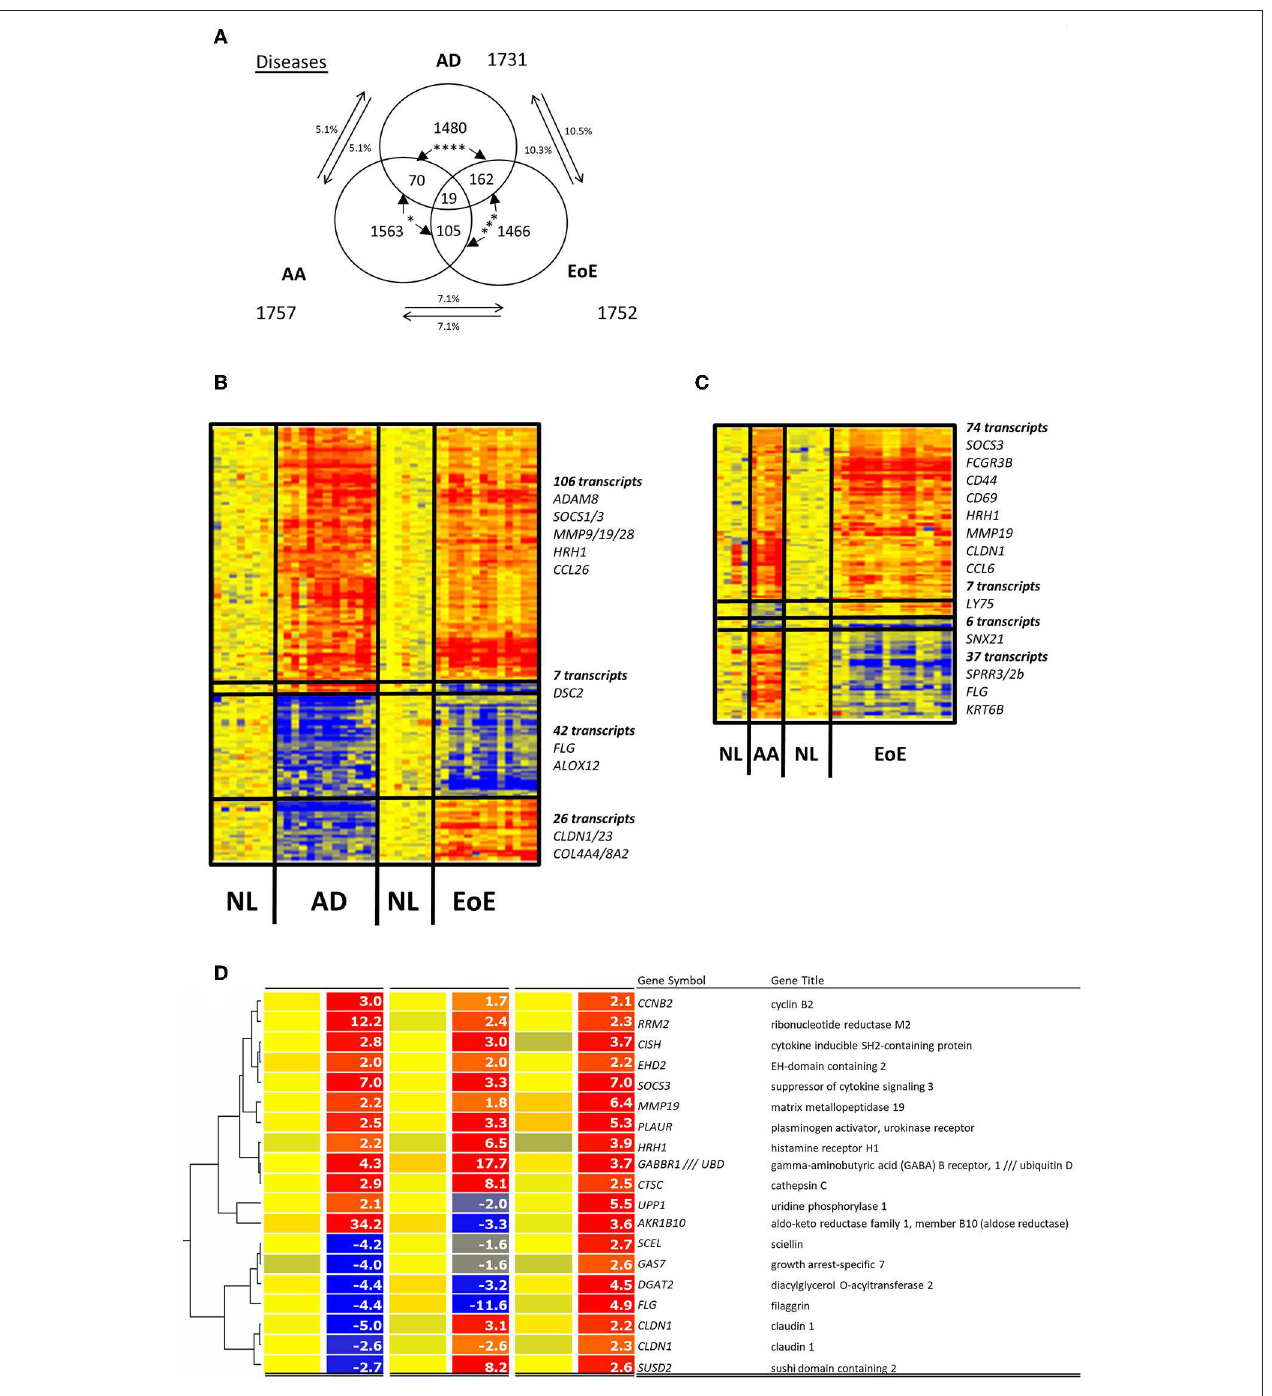
FIGURE 1 | Comparison of EoE, AD, and AA diseases. (A) Venn diagram of dysregulated transcripts in the three diseases is shown. The three amounts of dysregulated genes in EoE, AD, and AA diseases and their respective overlaps are shown, and the number of transcripts is indicated. The percentages of genes in each disease gene group that overlap with those of another disease are shown. Chi-square tests were used to compare transcript overlaps for each disease model with the two other diseases. P -values are shown for each comparison of overlap (between arrows); * p < 0.05; ***p < 0.0005; ****p < 0.0001. (B) Heatmap of the 181 transcripts dysregulated in AD and EoE. (C) Heatmap of the 124 transcripts dysregulated in AA and EoE. (D) Heatmap of the 19 dysregulated probes common to the three diseases. NL, normal controls.